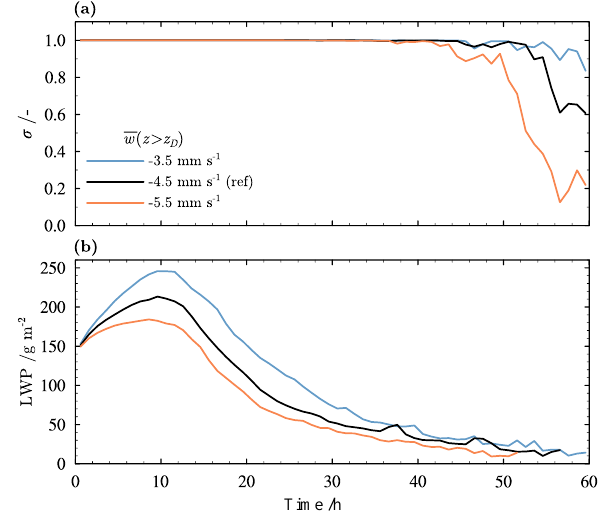
Figure 3. (a) The projected cloud cover σ and (b) the LWP as a function of time for the sensitivity simulations in which the large- scale subsidence velocity is varied as indicated by the